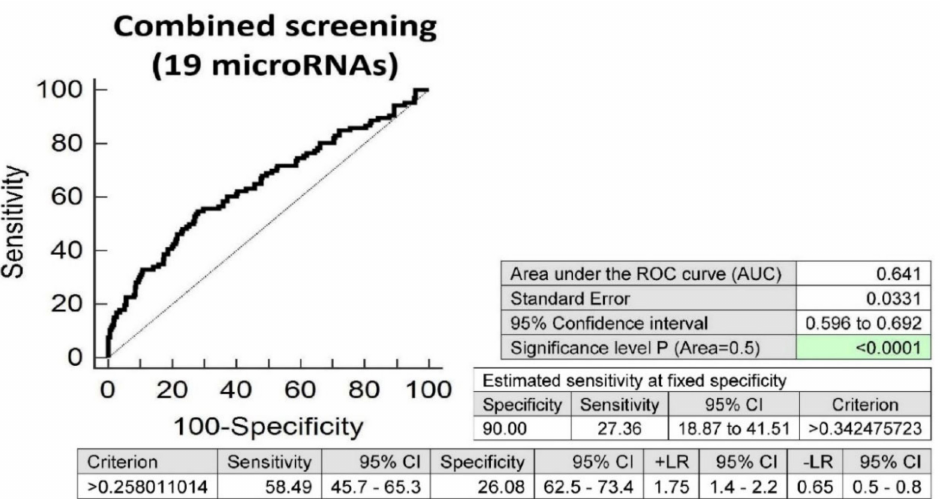
Figure 6. Aberrant microRNA expression profile in children with valve problems or heart defects descending from complicated pregnancies. Combined screening revealed that at 10.0% FPR, 27.36% of children with valve problems or heart defects had a substantially altered microRNA expression profile (miR-1-3p, miR-16-5p, miR-17-5p, miR-20a-5p, mir-20b-5p, miR-21-5p, miR-26a-5p, miR-29a-3p, miR-100-5p, miR-125b-5p, miR-126-3p, miR-143-3p, miR-146a-5p, miR-181a-5p, miR-195-5p, miR-221-3p, miR-342-3p, miR-499a-5p and